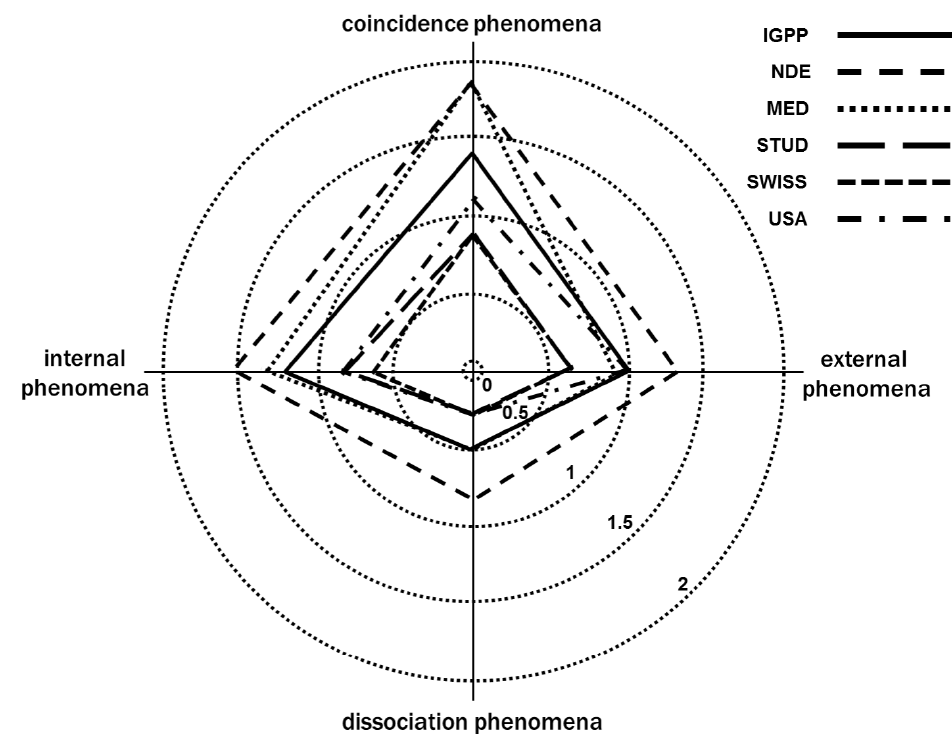
Figure 4. Frequencies of the four basic classes of phenomena from the six samples mentioned in the text. Dotted circles represent frequency levels as assessed individually on a scale from 0 (never) to 4 (very often). IGPP—sample 4, NDE—sample 5, MED—sample 6, STUD–sample 2, SWISS—-sample 1, USA—sample